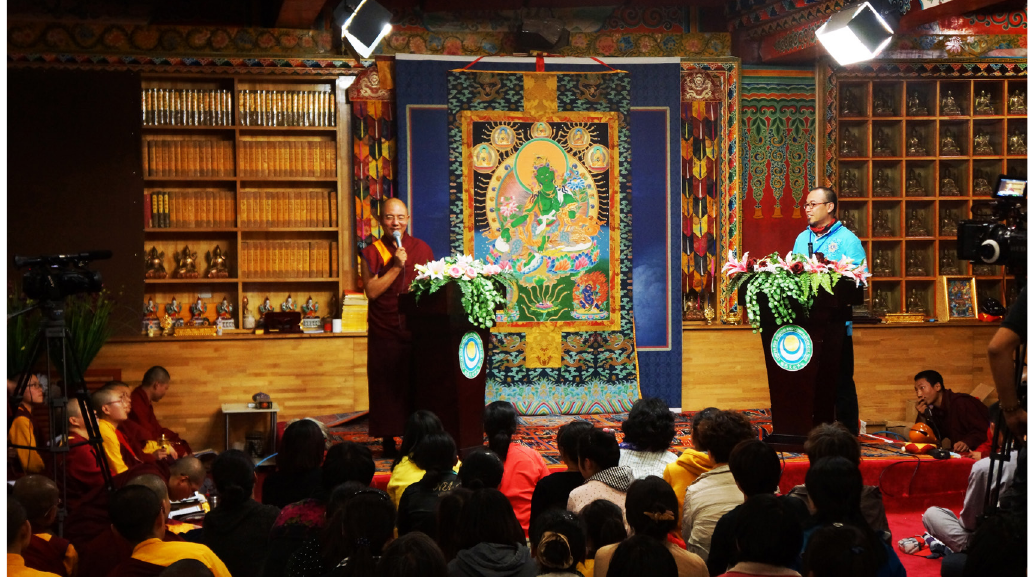
Figure 1. The authors’ Buddhism-Social Science Dialogue Session at Larung Gar Buddhist Academy, Sertar County, Sichuan Province, PRC, August 2013. Photo by Sonam